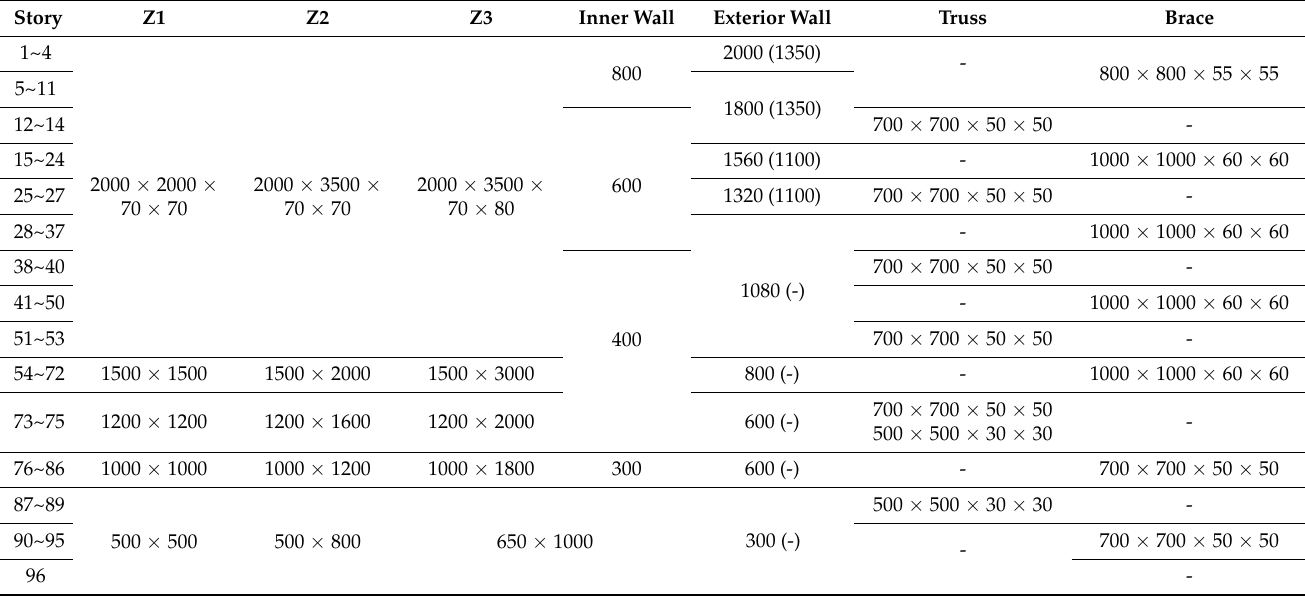
Table 5. Member size of vertical components (unit: